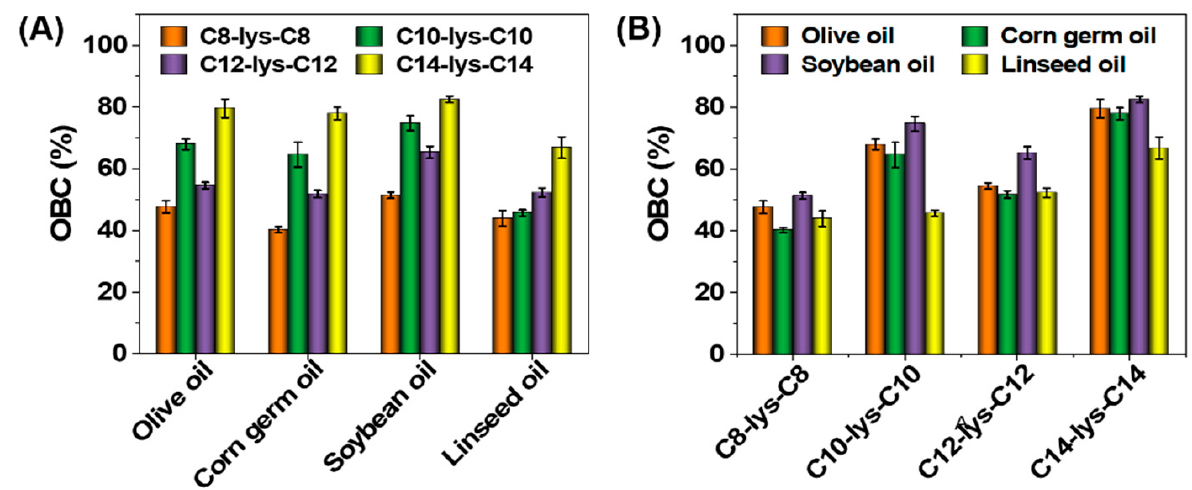
Figure 6. OBC of oleogels formed by four L -lysine-based gelators in different vegetable oils: ( A ) Comparison of different gelators, ( B ) Comparison of different oils.